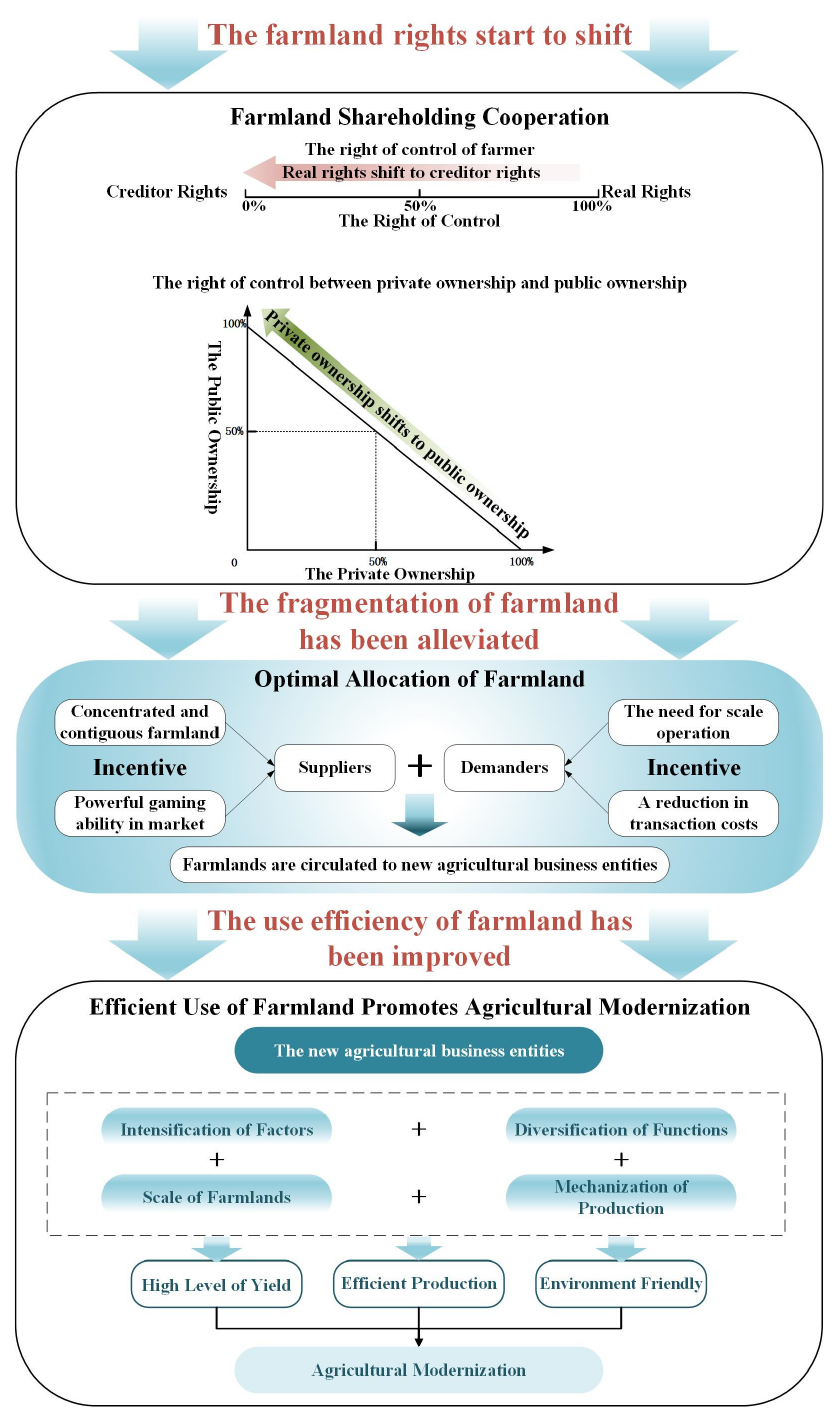
Figure 3. The theoretical approach of reform promoting agricultural modernization.